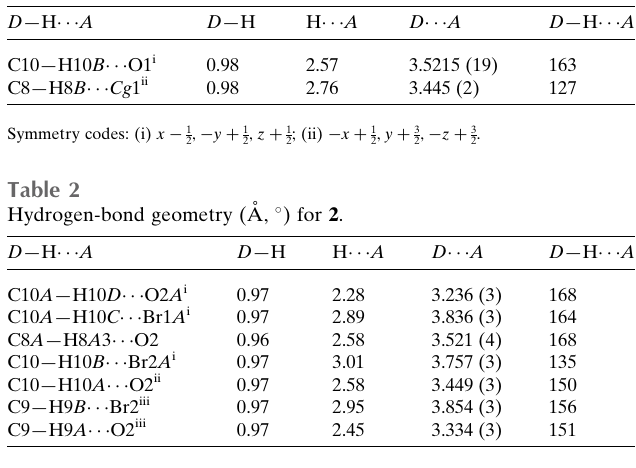
Table 1 Hydrogen-bond geometry (A˚ , (cid:3) ) for 1 . Cg 1 represents the centroid of the C1–C6 ring.